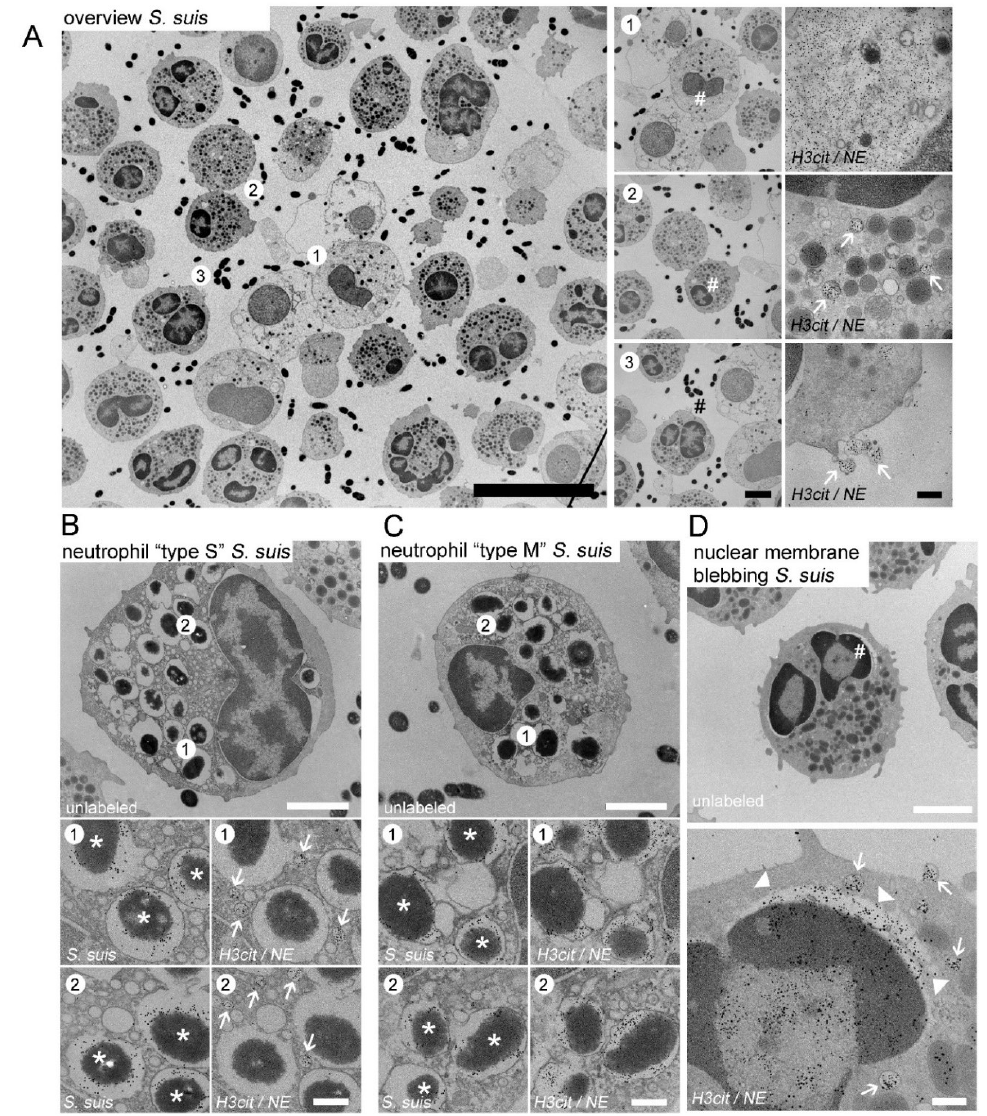
Figure 3. ( A – D ) Representative TEM images taken during one experimental run of porcine neutrophils after 30 min of S. suis infection; ( A ) Overview picture, ( area 1 ) neutrophil containing NE and H3cit in the cytoplasm; ( area 2 ) neutrophil containing NE and H3cit in vesicles (white arrows); ( area 3 ) neutrophil releasing NE and H3cit positive vesicles in the extracellular space (white arrows); ( B ) Neutrophil “type S”: gold-labeling of two serial sections identified neutrophils with phagocytosed S. suis (serial Section 1, left panel, white stars mark S. suis ) and clearly outside all bacteria-containing phagosomes separated NE/H3cit positive vesicles (serial Section 2, right panel, white arrows mark vesicles); ( C ) Neutrophil “type M”: gold-labeling of two serial sections identified neutrophils with phagocytosed S. suis (serial Section 1, left panel, white stars mark A.pp ) and these phagosome are in addition NE/H3cit positive (serial Section 2, right panel); ( D ) The hash marks in the upper panel the zoom area. Neutrophils after S. suis infection showing nuclear membrane blebbing (NE/H3cit positive gold-labeled, white arrow heads) and vesicles (NE/H3cit, white arrows). Furthermore, NE positive granule and a NE/H3cit positive nucleus were identified; ( A – C ) (right panels with zoom pictures) and D lower panel: 5 nm gold labeling = H3-cit and 10 nm gold labeling = NE; ( B , C ) (left panels with zoom pictures) 10 nm gold labeling = S. suis . Scale bars in A: overview = 10 µm; zoom pictures = 2.5 µm; zoom and gold-labeling = 200 nm; ( B – D ) 2 µm (upper panel) and 250 nm (lower panels).